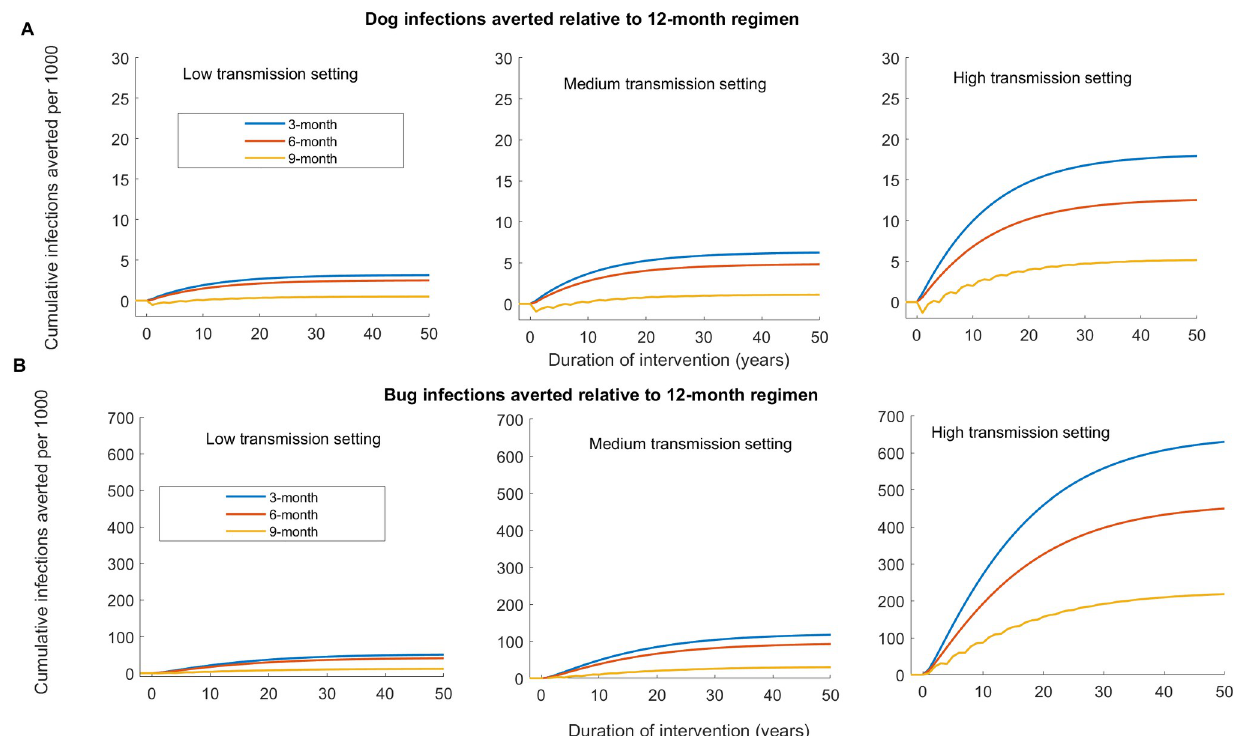
Fig 6. Relative effectiveness of dog treatment regimen for reducing T . cruzi infections among dogs and triatomines compared to a 12-month treatment regimen using Model 2. Effectiveness is computed using the single host-vector model with seasonality. (A) Cumulative additional dog infections averted under the 3-month, 6-month, and 9-month regimen relative to the 12-month regimen in the low, medium, and high transmission settings. (B) Cumulative additional triatomine infections averted under the 3-month, 6-month, and 9-month regimen relative to the 12-month regimen in the low, medium, and high transmission